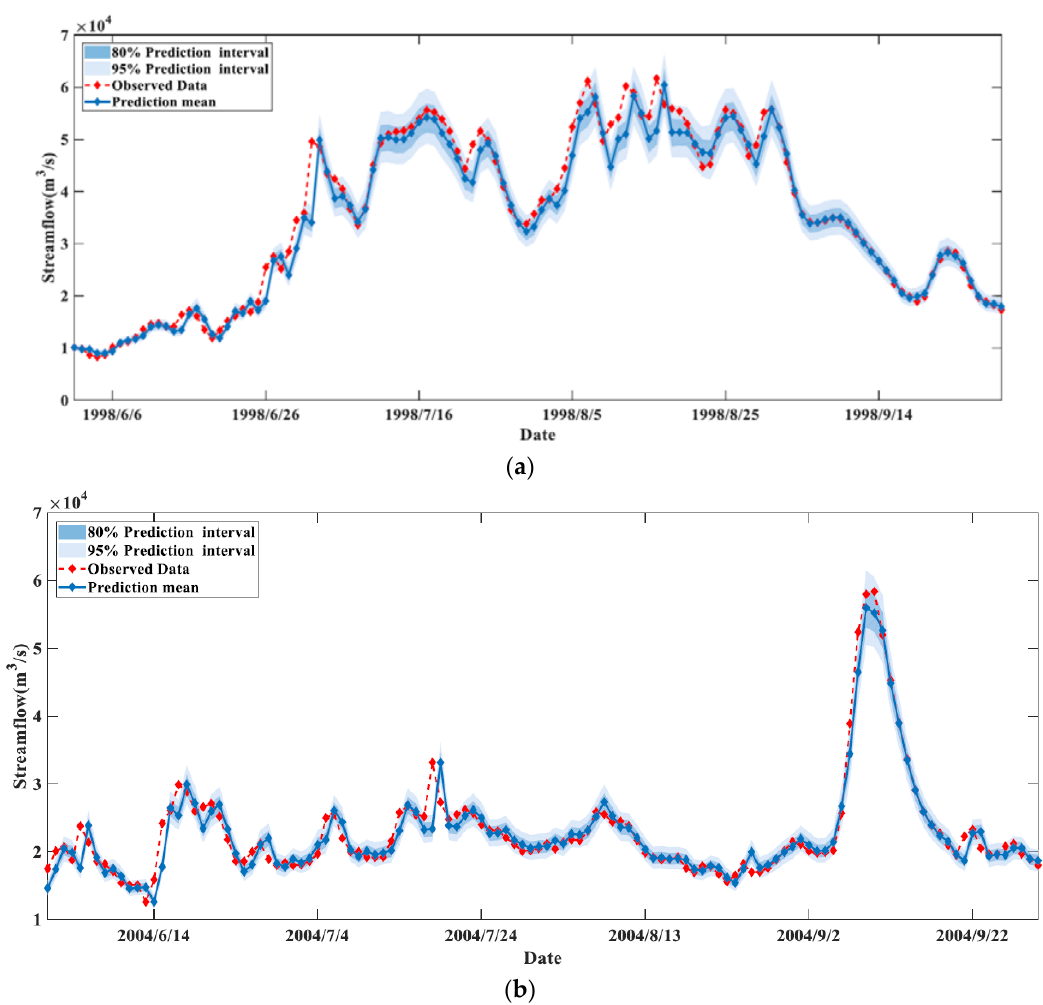
Figure 7. Uncertainty estimation of forecasts in ( a ) 1998 and ( b ) 2004 (blue line, forecast mean; red line, observed streamflow; blue band, 80% prediction interval; light blue band, 95% prediction interval).